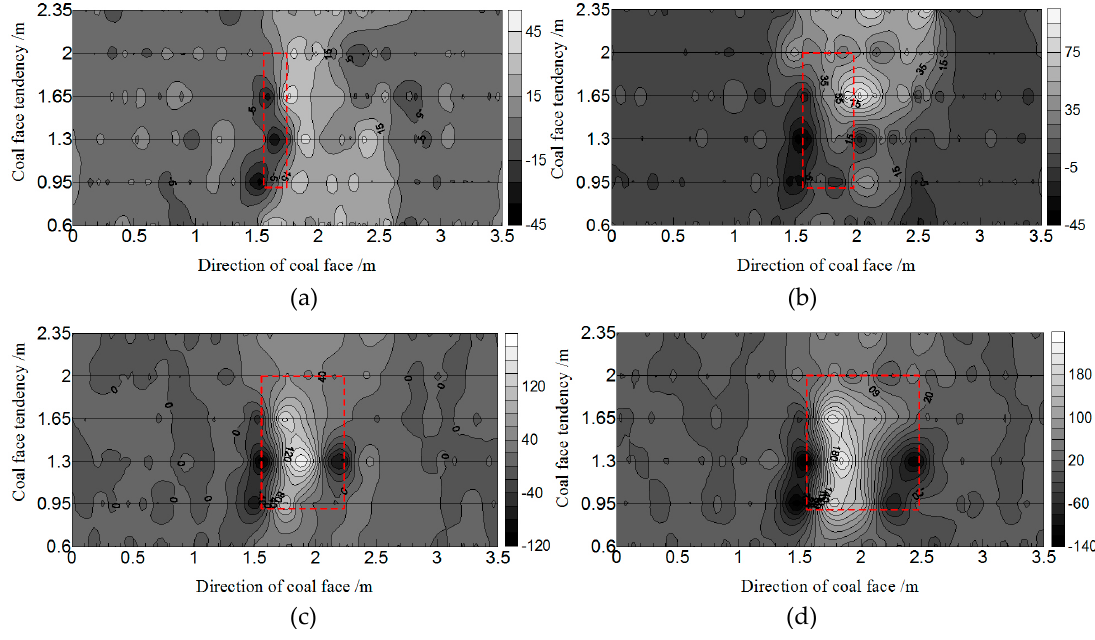
Figure 7. Strain contour map of layer II: ( a ) the 2nd strip mined; ( b ) the 5th strip mined; ( c ) the 8th strip mined; and ( d ) the 11th strip mined (unit: 10 − 6 ).